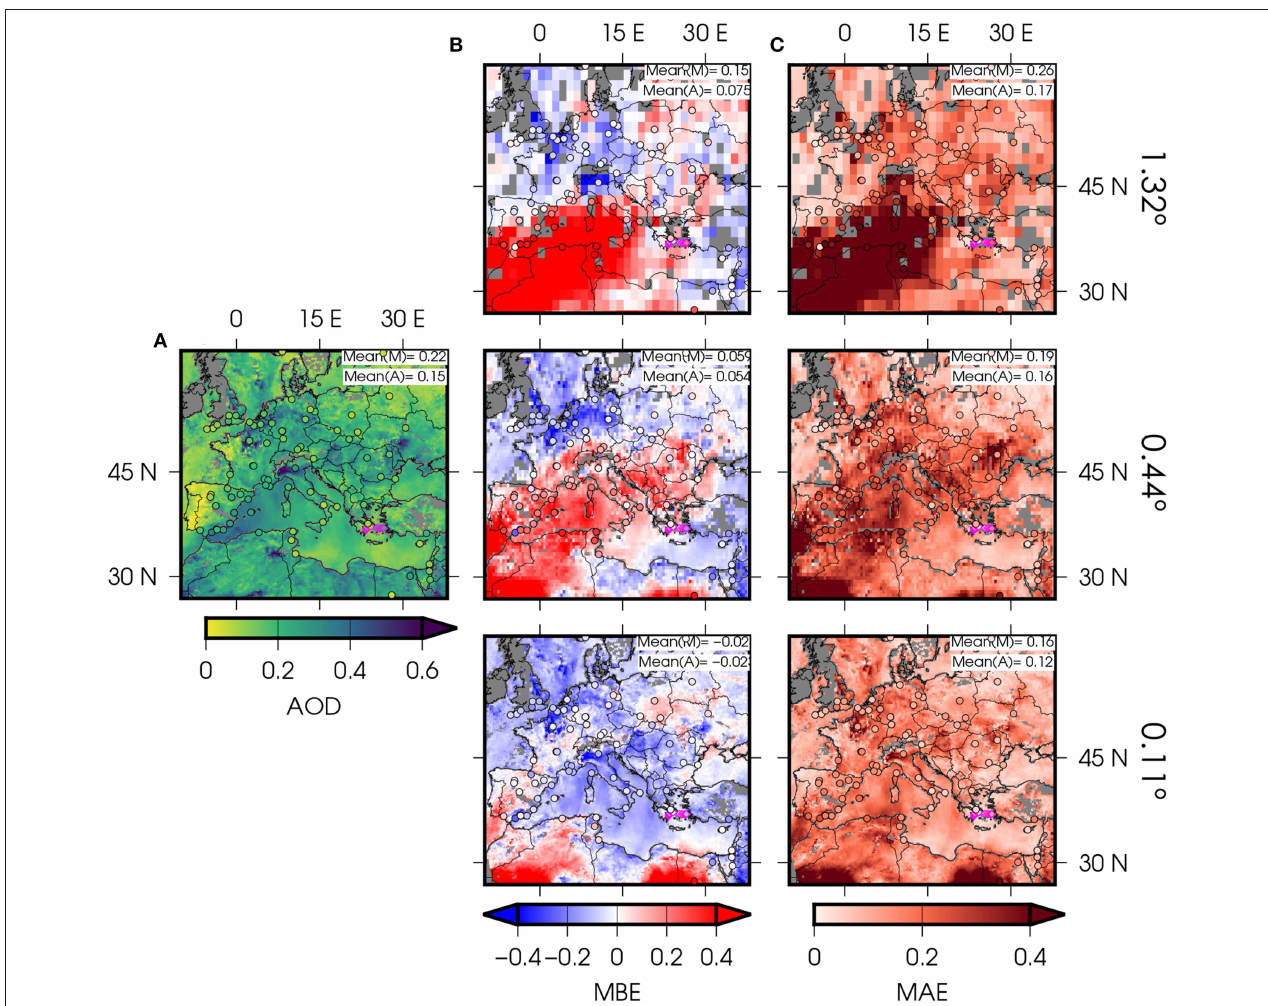
FIGURE 3 | Aerosol optical properties evaluation. (A) AOD (550 nm ) from satellite (shadow), MAN network (diamonds) and AOD (675 nm ) from AERONET (points). In second and third columns show the same as first but for: (B) MBE and (C) MAE. Top, the coarsest resolution (1.32 ◦ ), center (0.44 ◦ ), and bottom (0.11 ◦ ), the finest